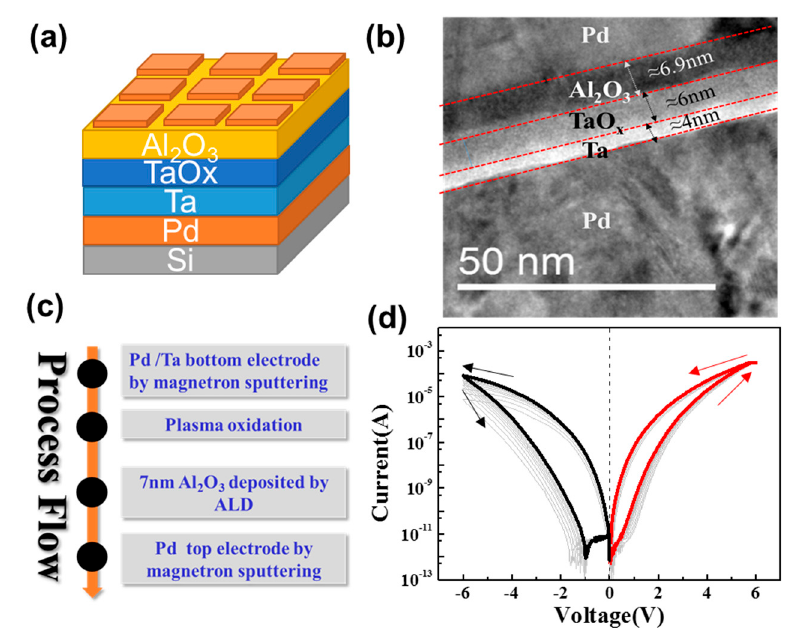
Figure 1. ( a ) The schematic, ( b ) a cross sectional transmission electron microscopy (TEM) image of the Ta/TaO x /Al 2 O 3 /Pd device, ( c ) the fabrication processes of the Ta/TaO x /Al 2 O 3 /Pd device, and ( d ) typical I–V curves of the Ta/TaO x /Al 2 O 3 /Pd showing bipolar analog switching (SET voltage = 6 V, RESET voltage = − 6